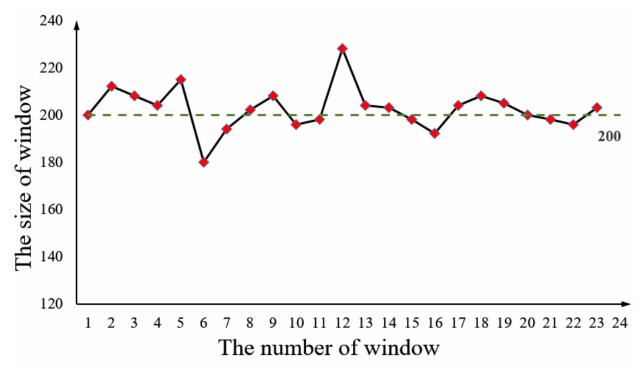
Figure 6. The curve of the sliding window size.